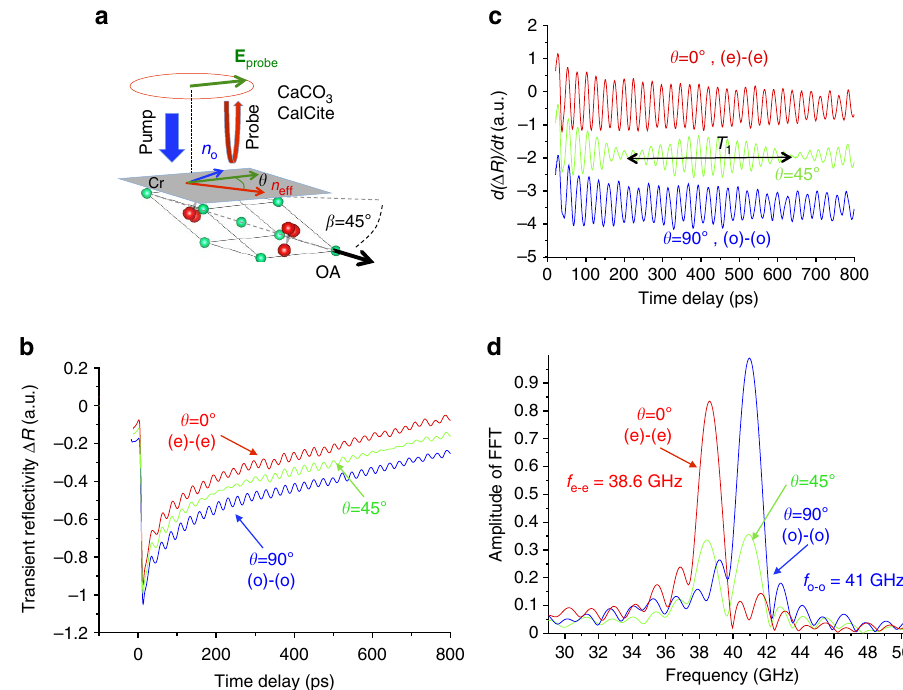
Figure 3 | Time-resolved Brillouin signal in birefringent calcite crystal. ( a ) Sketch of the pump–probe experiment carried out on calcite (CCO). The calcium and oxygen atoms are depicted in green and red, respectively, whereas the carbon atoms occupy the centre of the oxygen triangle. The Calcite is covered by a thin chromium film (Cr) which acts as an optoacoustic thermoelastic transducer. The time-resolved Brillouin process is investigated with a controlled variable polarization of the probe beam ( E probe ). ( b ) Typical transient reflectivity signal for different linear probe polarizations ( y ¼ 90 (cid:2) for ordinary and y ¼ 0 (cid:2) for extraordinary). ( c ) Time derivatives of the transient optical signals shown in b . T 1 is the beating period coming from the interferences of the two Brillouin modes (o-o) and (e-e). ( d ) FFTs of the transient optical reflectivity signals revealing the Brillouin frequencies f o (cid:2) o and f e (cid:2) e in full agreement with the expected values. For intermediate polarization, both modes are seen simultaneously (green curve). NATURE COMMUNICATIONS|7:12345|DOI: